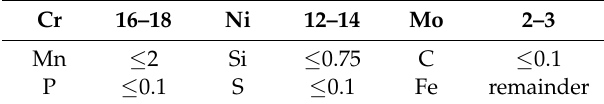
Figure 1. A flow chart of the work.